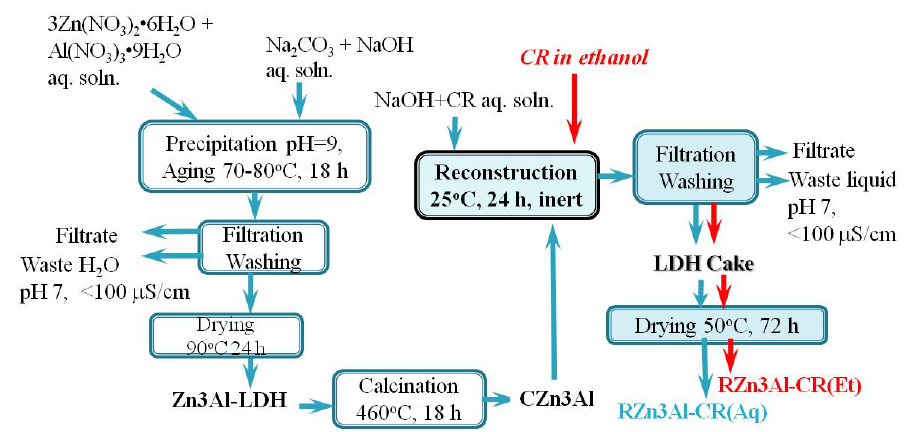
Figure 3. Flowchart for the preparation of CR-containing Zn3Al-LDH by reconstruction.